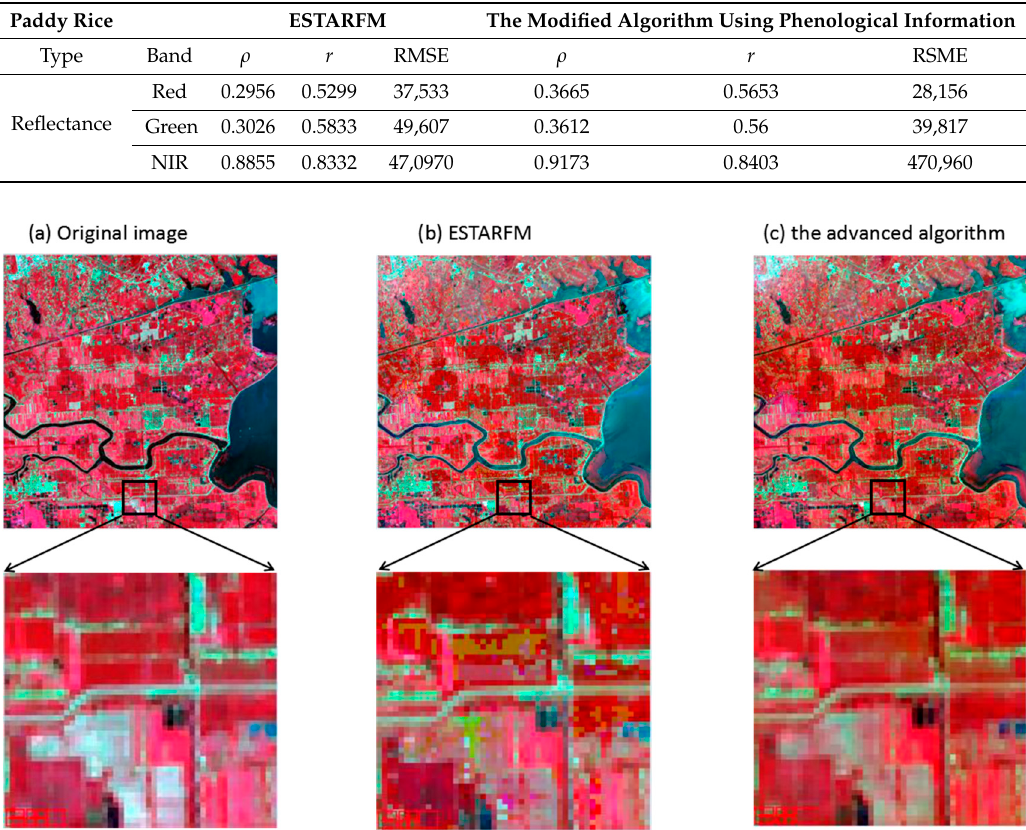
Table 2. Regression coefficient of the linear fitting equation, correlation coefficient, and root mean square error for 19 July 2016, and predicted reflectance compared with real reflectance on 23 July 2016, for paddy rice.